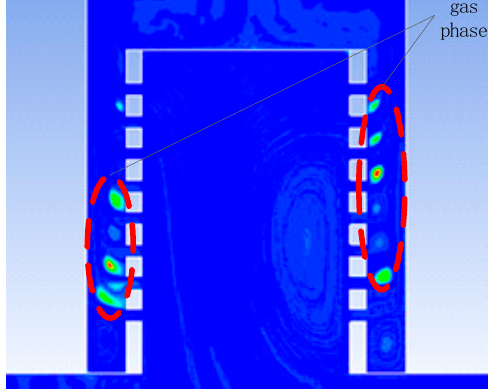
Figure 11. Gas fraction near the nozzle under the high temperature inlet.